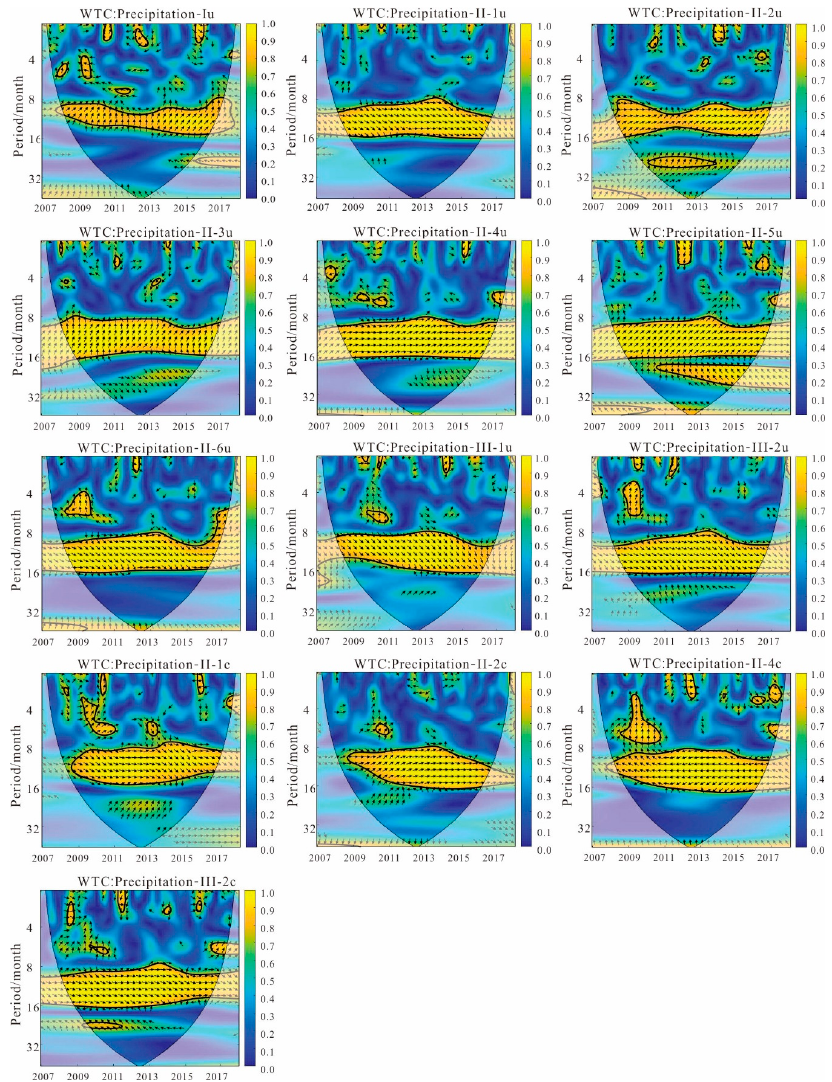
Figure 14. WTC (Wavelet Transform Coherence) analysis of precipitation and groundwater depth in different hydrogeological zones. The precipitation-Iu, precipitation-II-1u, precipitation-II-2u, precipitation-II-3u, precipitation-II-4u, precipitation-II-5u, precipitation-II-6u, precipitation-III-1u, and precipitation-III-2u subgraphs show the results of WTC analysis of precipitation and groundwater depth of the unconfined aquifer in the I, II-1, II-2, II-3, II-4, II-5, II-6, III-1, and III-2 hydrogeological zones. The precipitation-II-1c, precipitation-II-2c, precipitation-II-4c, and precipitation-III-2c subgraphs show the results of WTC analysis of precipitation and groundwater depth of the confined aquifer in the II-1, II-2, II-4, and III-2 hydrogeological